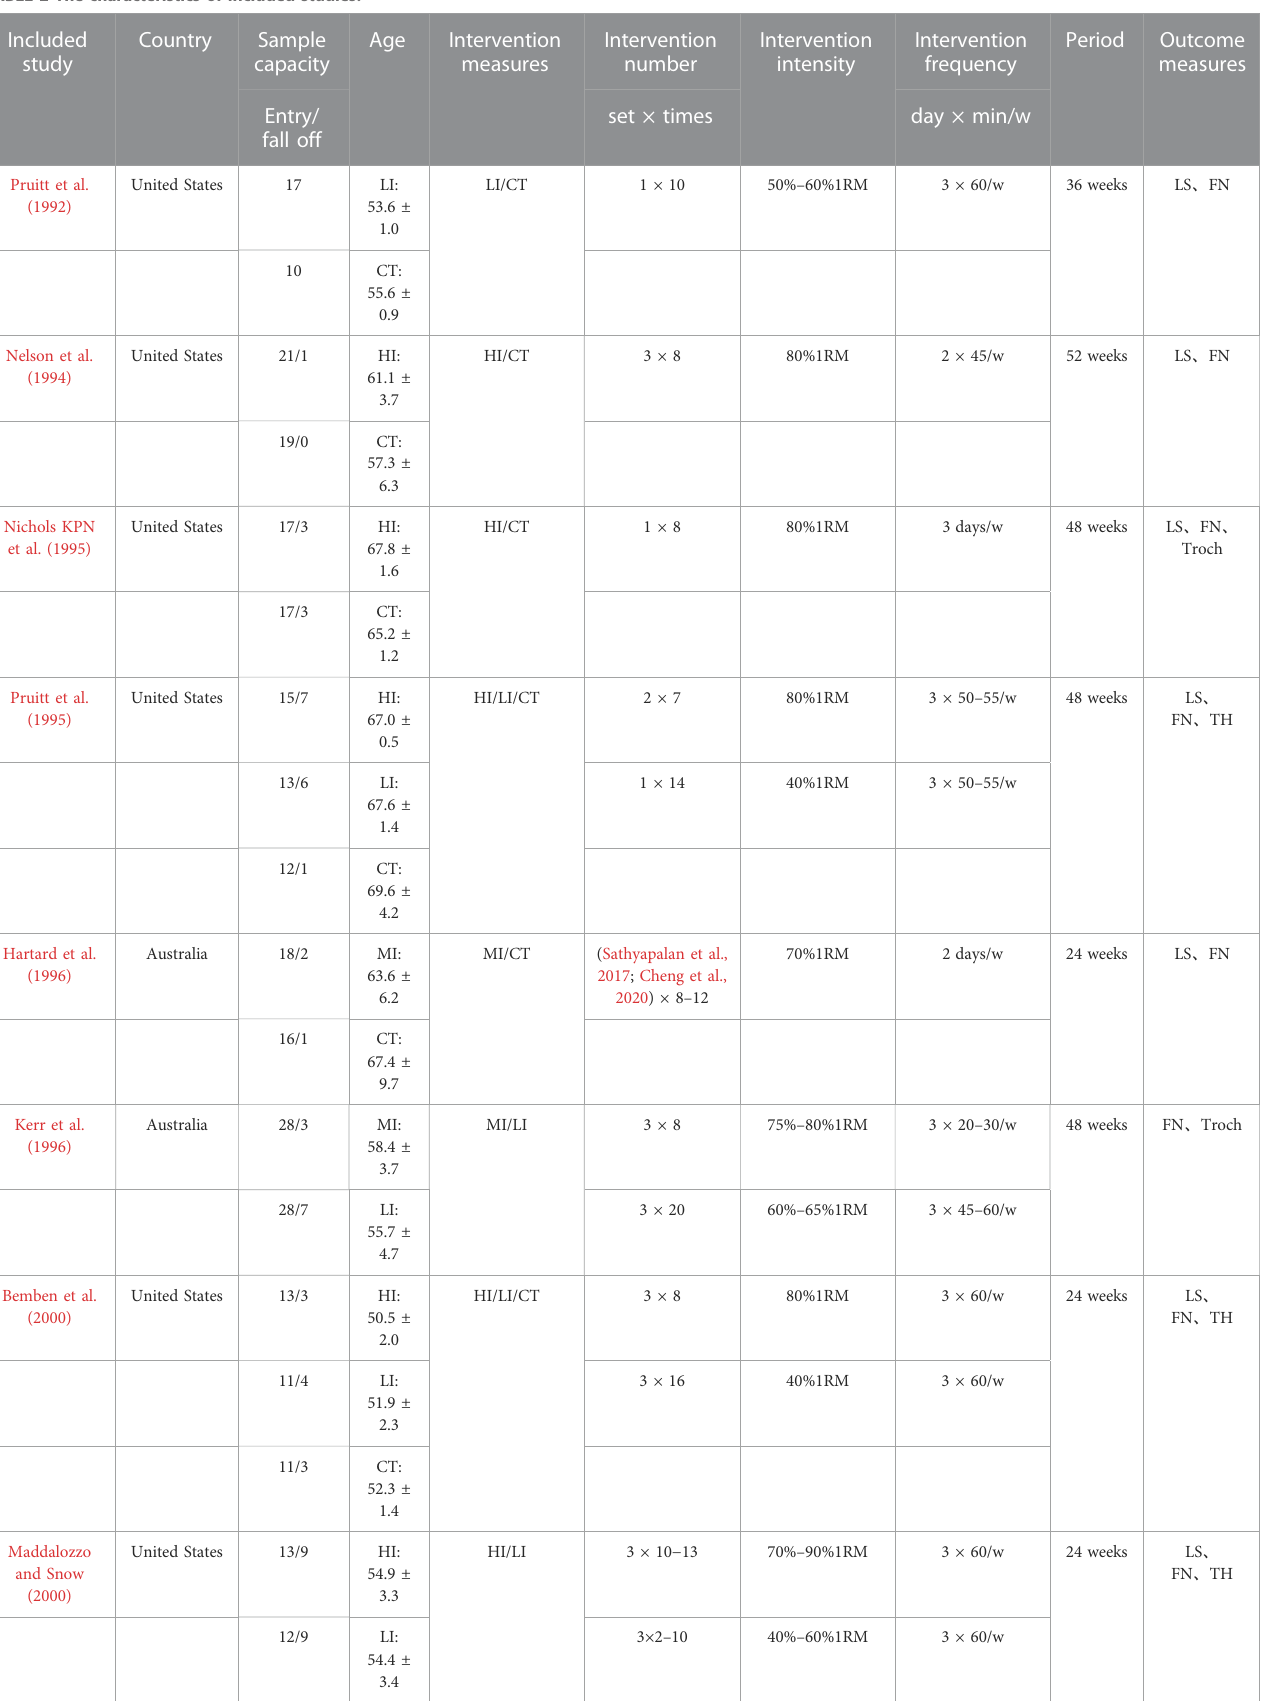
TABLE 2 The characteristics of included